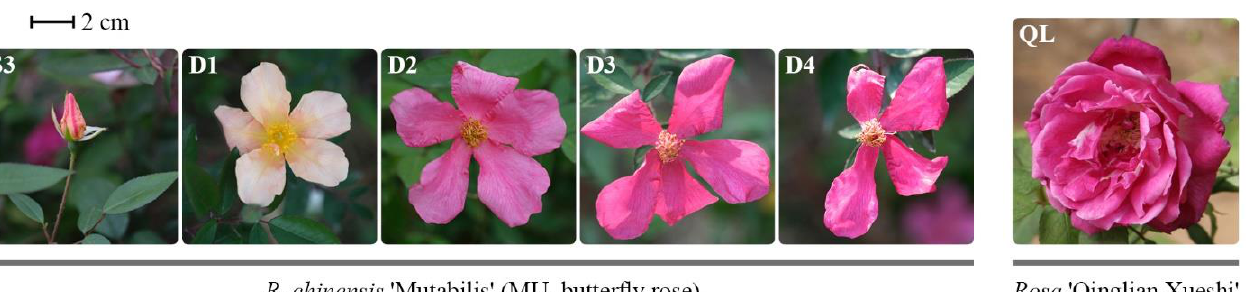
Figure 1. Photos of butterfly rose ( R. chinensis ‘Mutabilis’) at different floral developmental stages and Rosa ‘Qinglian Xueshi’. S3: bud about to open; D1: first day of anthesis; D2: second day of anthesis; D3: third day of anthesis; D4: fourth day of anthesis.